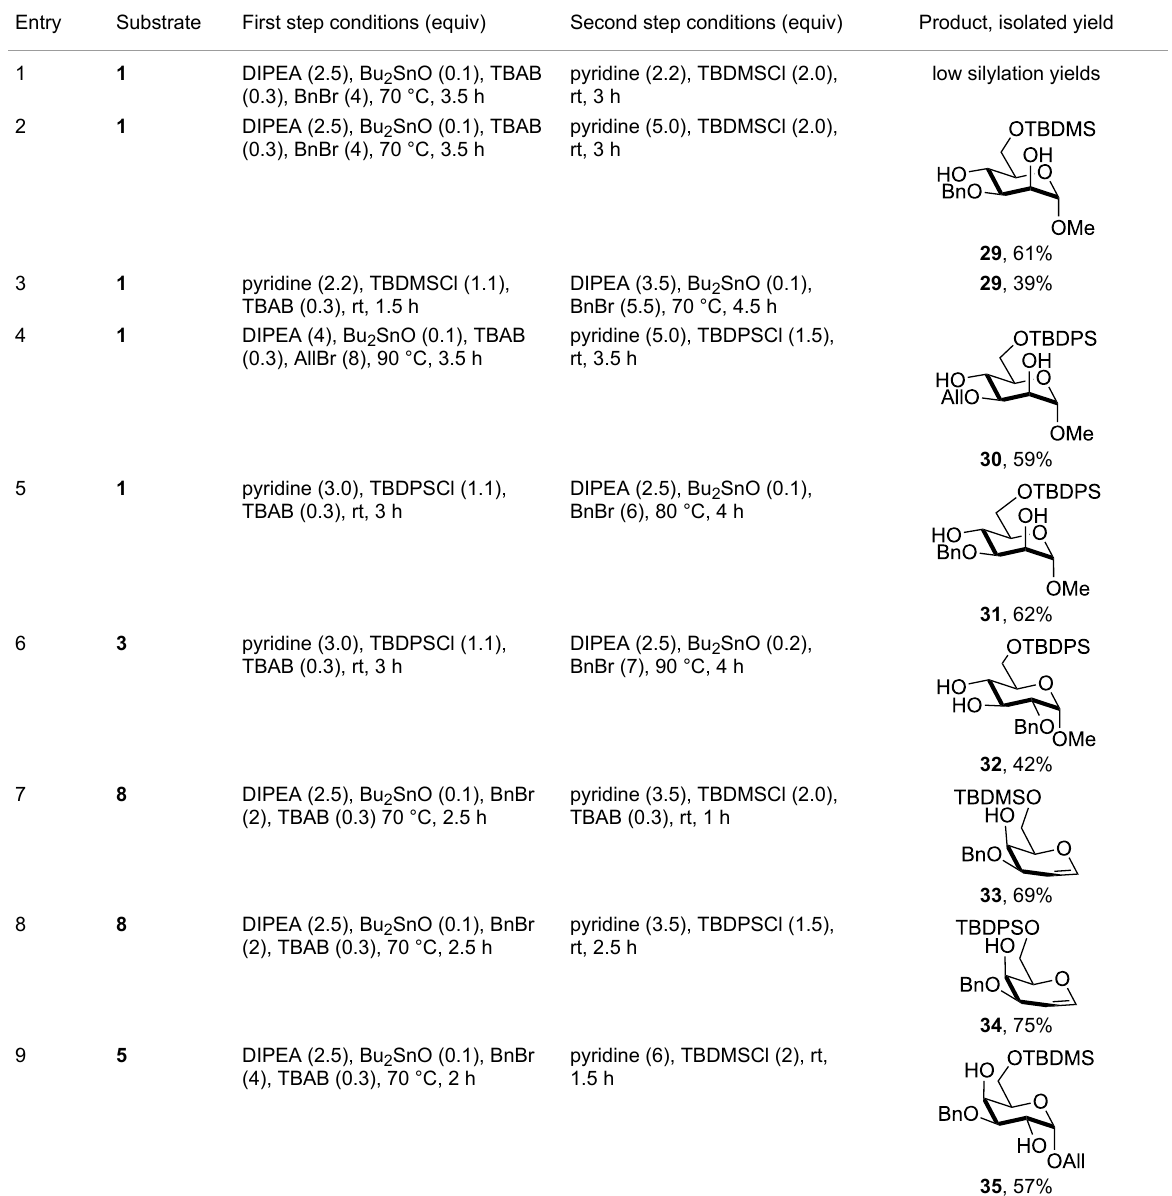
Table 4: One-pot, regioselective protection of sugar polyols with silyl and alkyl groups a . Entry